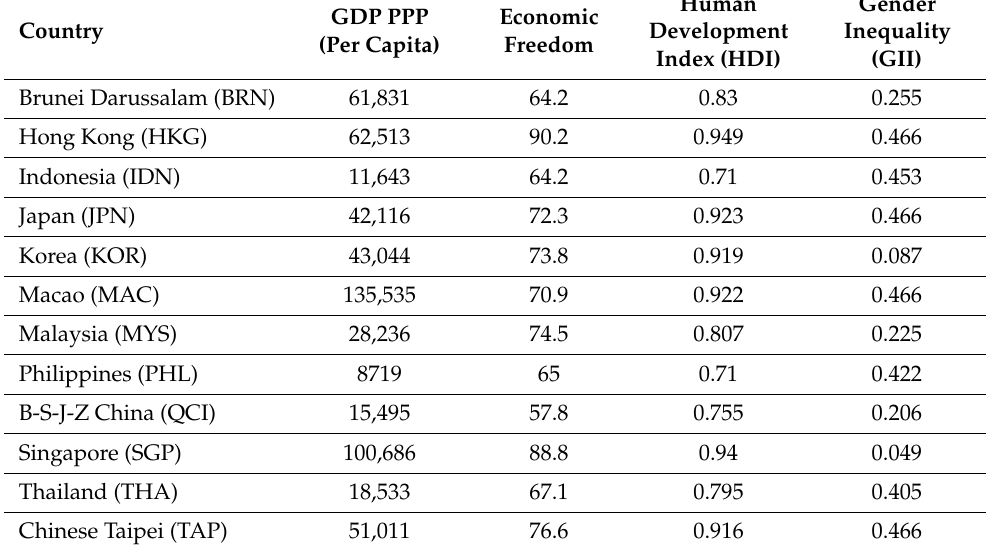
Table 3. Socio-economic